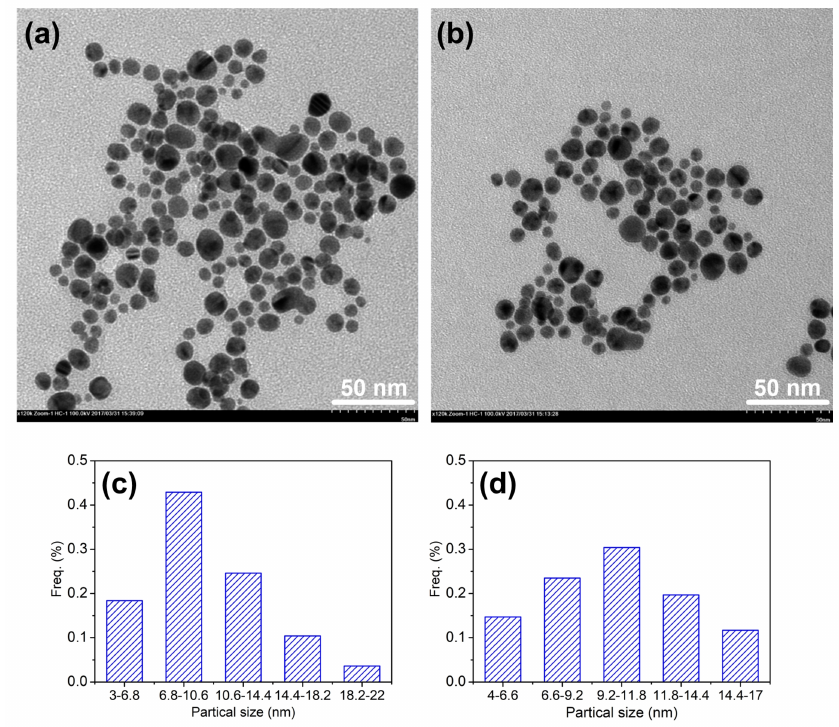
Figure 6. TEM images and their corresponding particle size distribution histograms for AgNPs prepared by quercetin ( a , c ) and rutin ( b , d